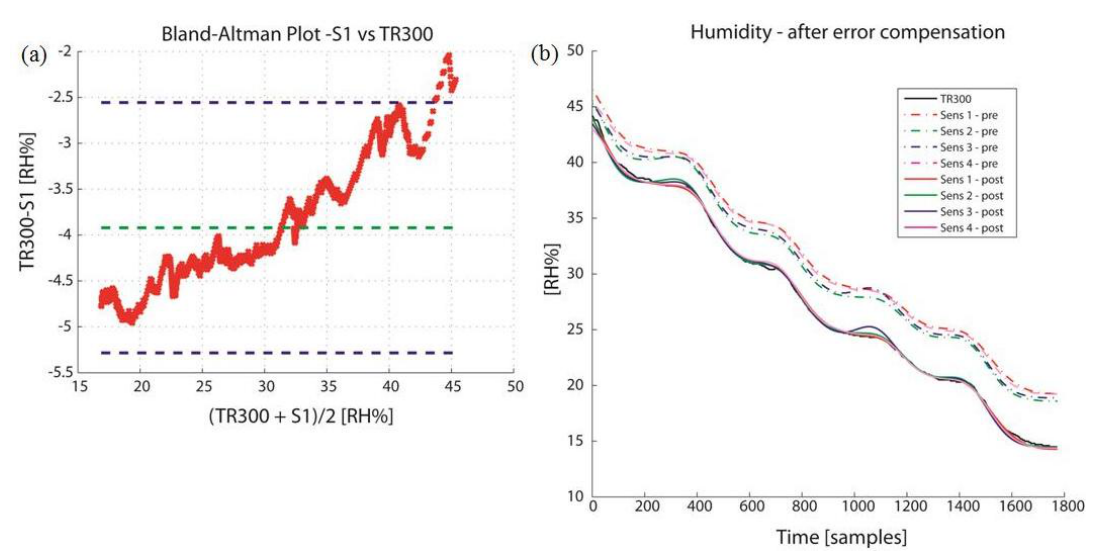
Figure 4. ( a ) Bland-Altman plot for S1 vs. TR300 for humidity. There is a clear correlation between the error ( y axis, TR300-S1, [RH%]) and the true value estimate ( x axis, 0.5  (TR300 + S1), [RH%]); ( b ) Humidity signals from Sensirion sensors, pre- and post-